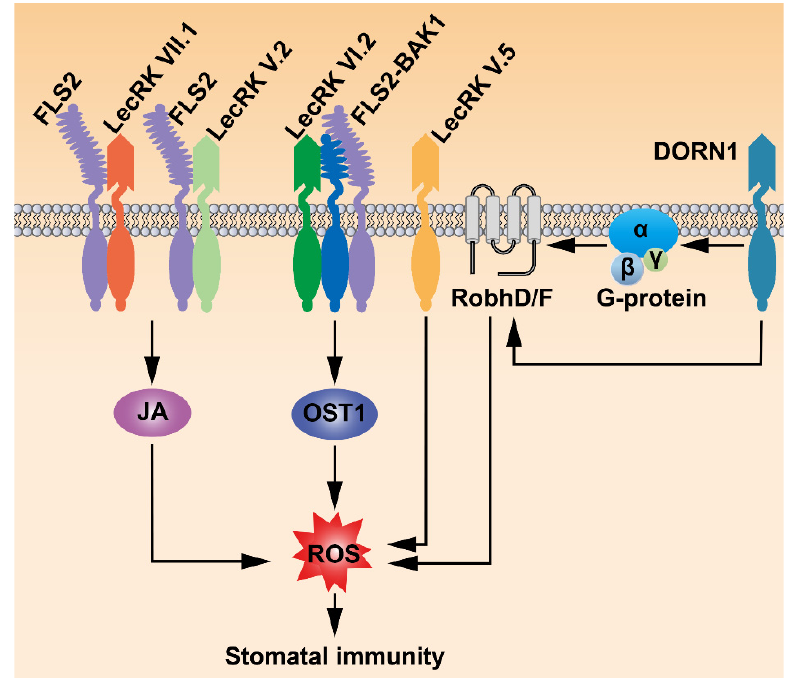
Figure 4. LecRKs regulate stomatal immunity. DOES NOT RESPOND TO NUCLEOTIDES 1 (DORN1/LecRK I.9) perceives extracellular ATP (eATP) to mediate the production of ROS in stomatal closure through G protein-dependent or -independent pathways. LecRK-VI.2 associates with the FLS2 PRR complex to regulate PAMP-induced stomatal immunity. LecRK-V.5 regulates stomatal immunity upstream of ABA-mediated ROS burst. LecRK-V.2 and LecRK-VII.1 function in a nonredundant way to regulate stomatal movement in immunity through the JA signal pathway.